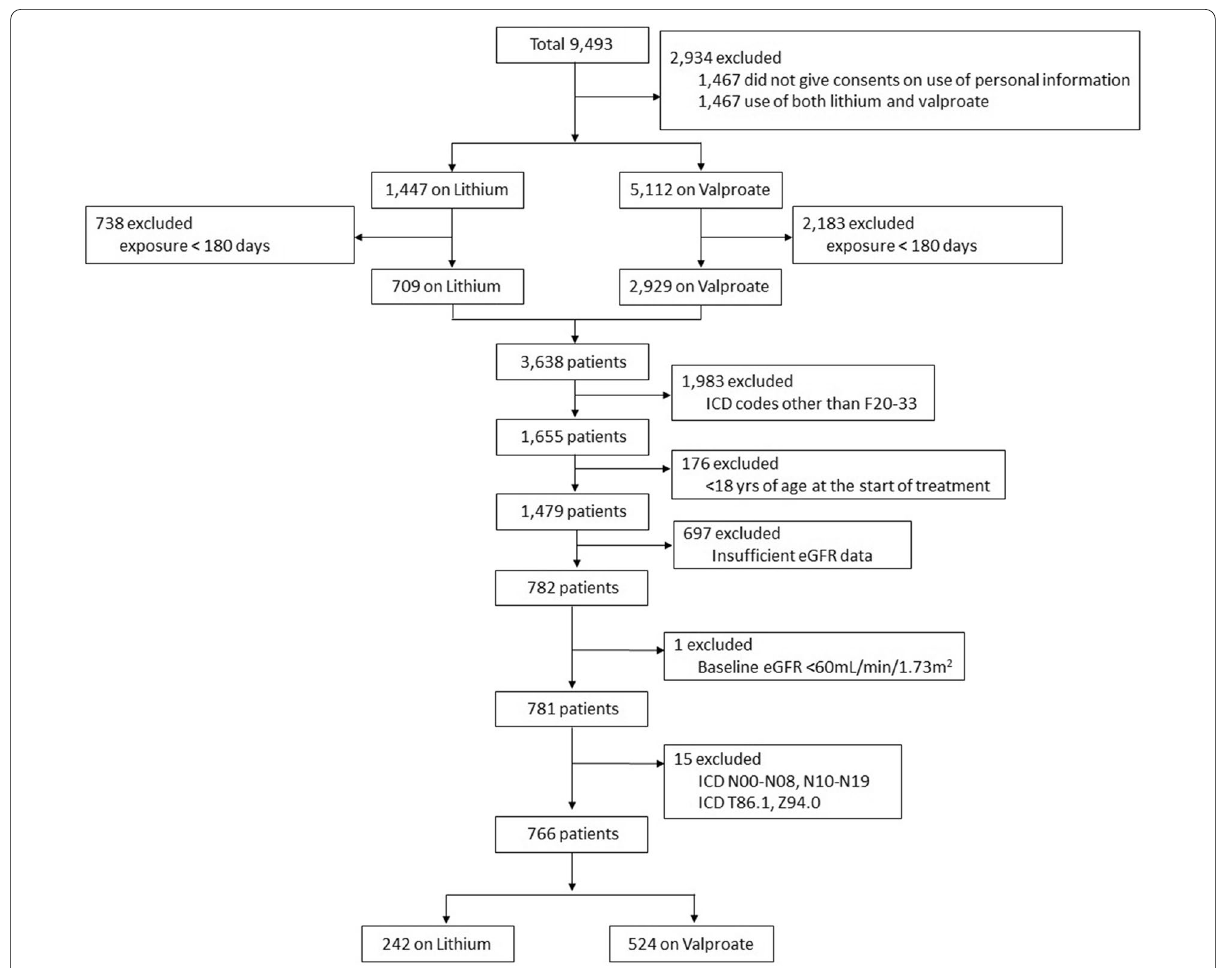
Fig. 1 Inclusion of the study